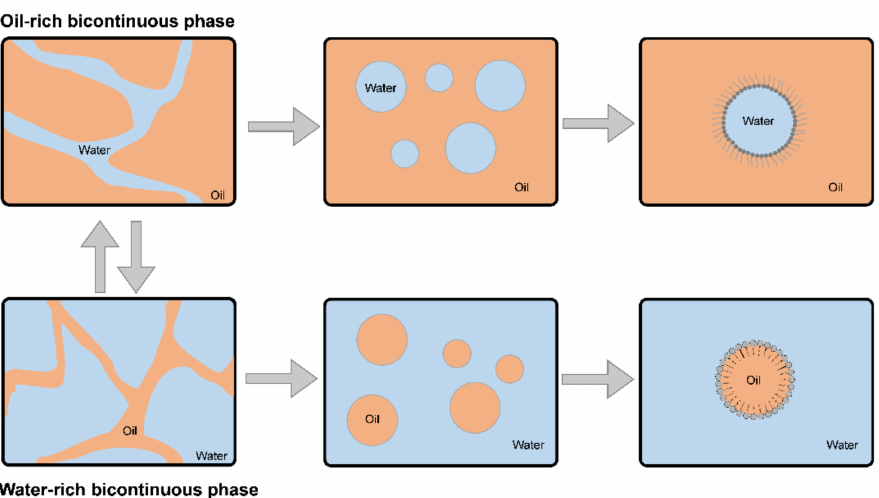
Figure 2. Representation of colloidal dispersions of o/w and w/o